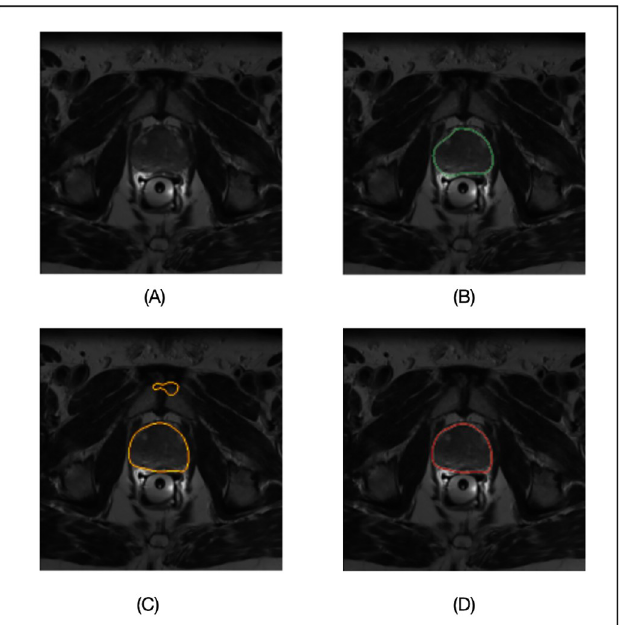
Fig 6. Prostate segmentation on MRI. (A) original image; (B) prostate reference segmentation (green contour); (C) segmentation of the prostate_whole_cnn node (the baseline results; yellow contour); (D) SimpleMind segmentation of the prostate_whole node